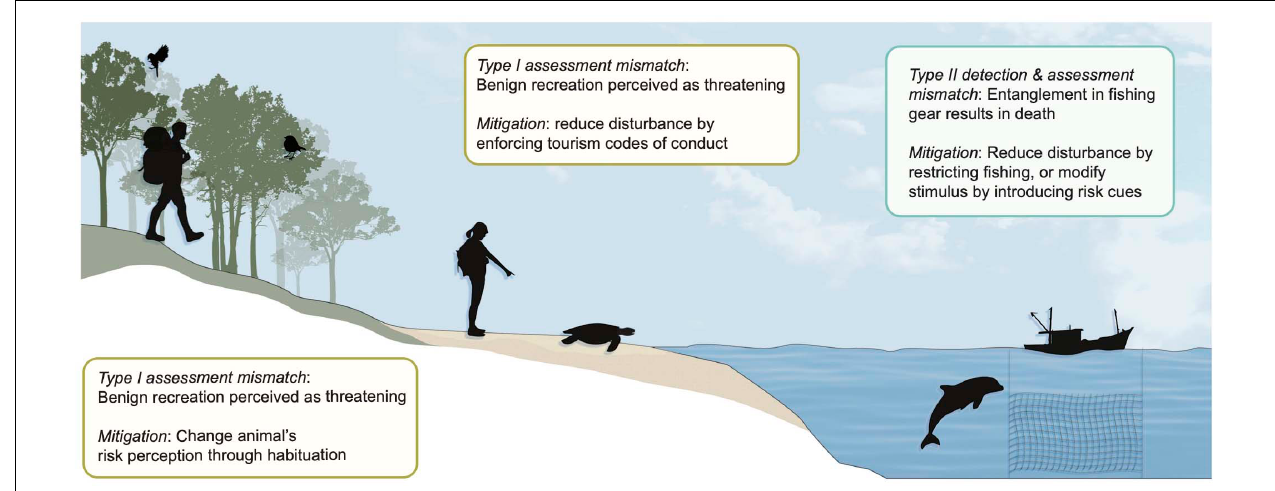
FIGURE 3 | Examples of mitigation measures for reducing risk-response mismatch in wild animals. Managers can employ several strategies to mitigate costly consequences of mismatch between anthropogenic risk and response in wild animal populations. The design of interventions should be informed by the type of mismatch (detection, assessment, or response, and Type I or II error), the nature of the anthropogenic stimulus, and the behavioral plasticity of the target species. One mitigation approach for Type II assessment errors is to gradually habituate animals to a benign stimulus, such as non-consumptive outdoor recreationists. Another strategy, which can be employed for all types of mismatch, is to reduce animal encounters with the disturbance stimulus by minimizing the disturbance (e.g., mitigating ecotourism-induced disturbances). The stimulus itself can also be modified to be more detectable (for Type II detection error) or more fear-inducing (for Type I or II assessment error) – these approaches can be employed to minimize fisheries